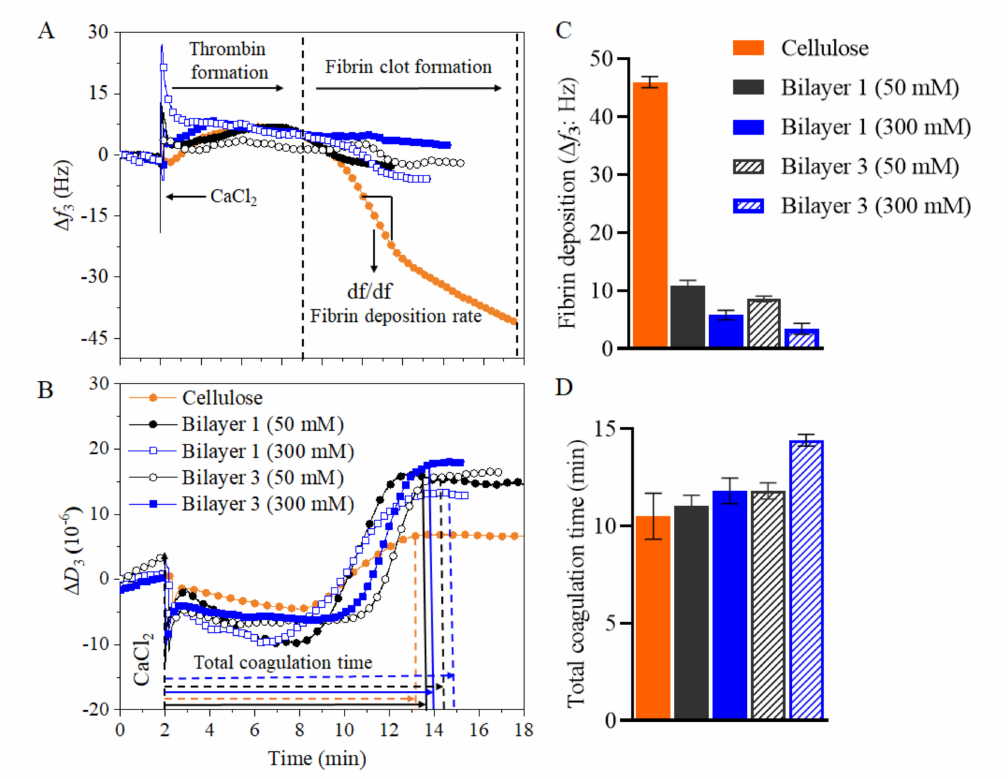
Figure 8. Fibrin clot formation by QCM-D on LBL assembled PEI/CNCs at 50 mM (full symbol) and 300 mM (empty/patterned symbol). Neat PEI and cellulose film as reference materials are shown as well. ( A ) Frequency ( ∆ f 3 ) and ( B ) dissipation ( ∆ D 3 ) changes during coagulation process, ( C ) total fibrin deposition, and ( D ) total coagulation